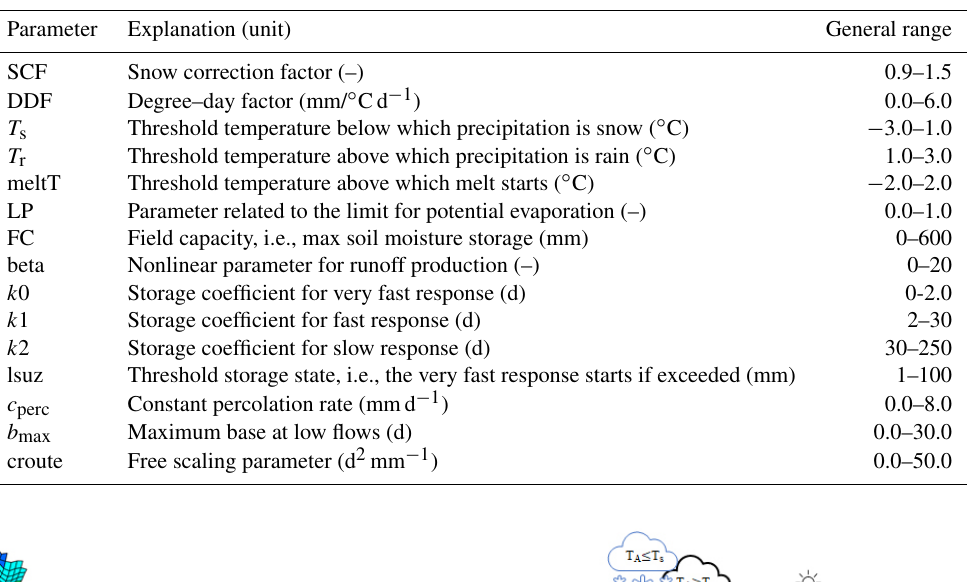
Table 2. Parameters of the hydrologic model (TUWmodel) and ranges used in model calibration. A suitable parameter range may vary by climate and land cover regions and is usually set by expert judgment. The range used here is based on the previous experience of Merz et al. (2011) and Viglione et al. (2013) in the study area.